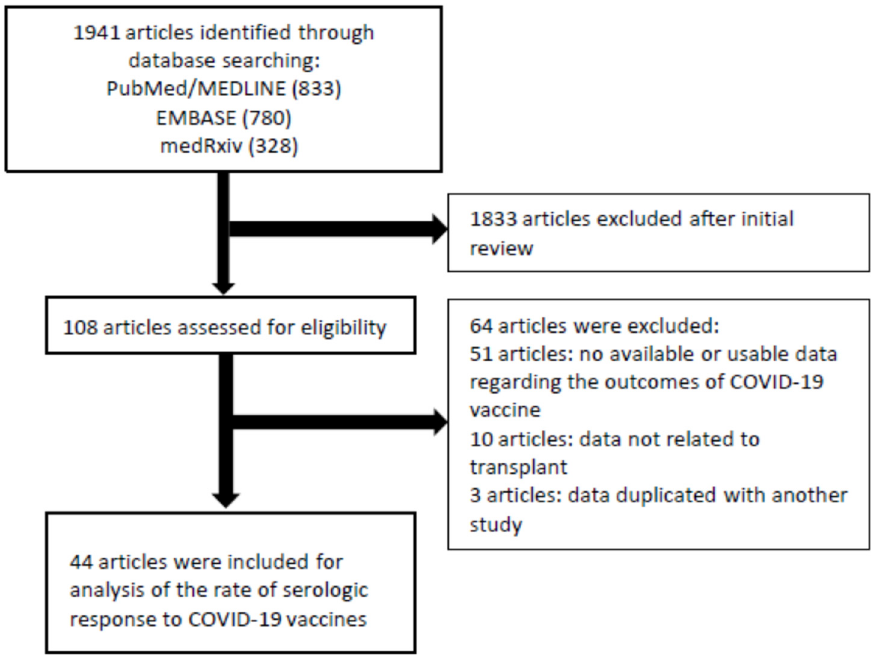
Figure 1. Flowchart of the assessment of the studies identified in the meta ‐ analysis.